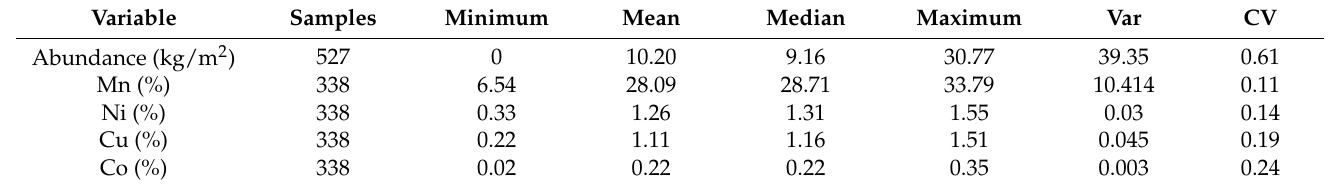
Table 4. Declustered statistics of all polymetallic nodule samples within the TOML exploration area.